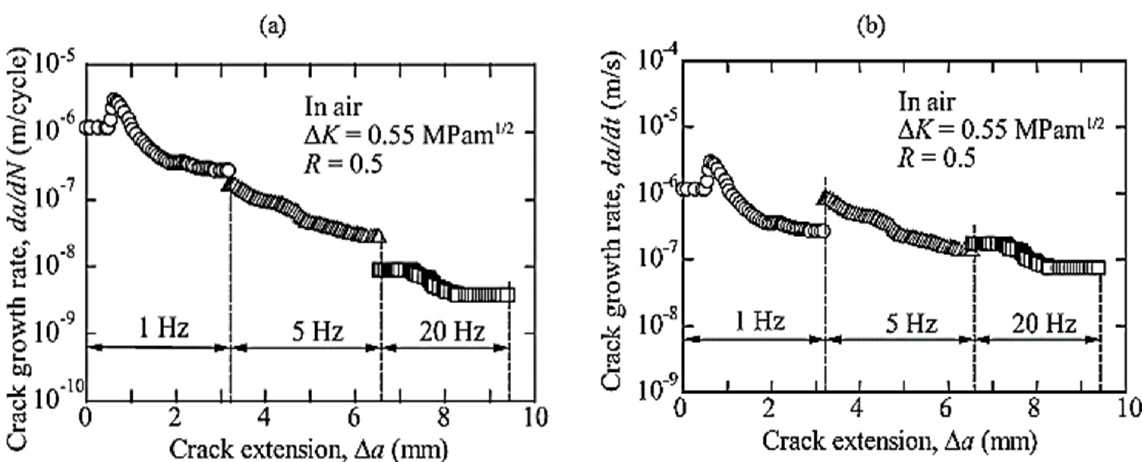
Figure 3. Impact of loading on mode 1 cracking of M4J/2500 laminates in air ( a ) cycle-dependent cracking rate, ( b ) time-dependent cracking rate [35].